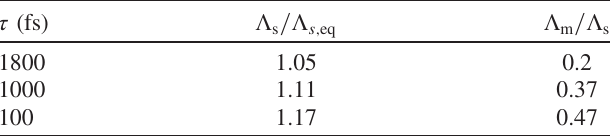
TABLE I. Model parameters for different pump-pulse widths. τ